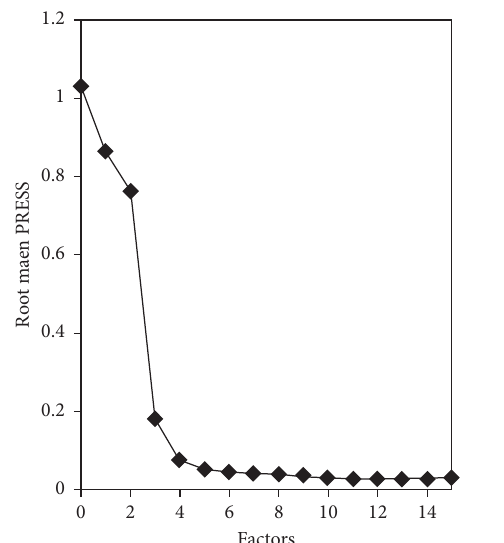
Figure 15: Plot of root mean PRESS against the number of factors for thirty-five CAR, CHL, and TEB mixtures for PLS-2